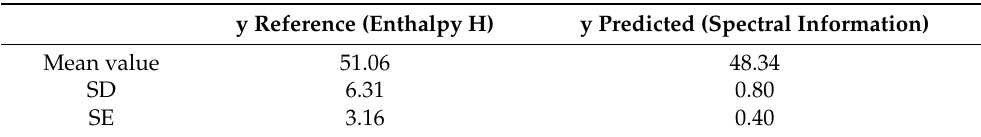
Table 2. Mean value, standard deviation (SD) and standard error of mean (SE) of center point repli-